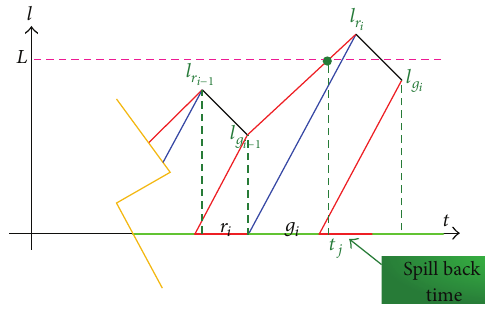
Figure 9: Spillover of road queue.